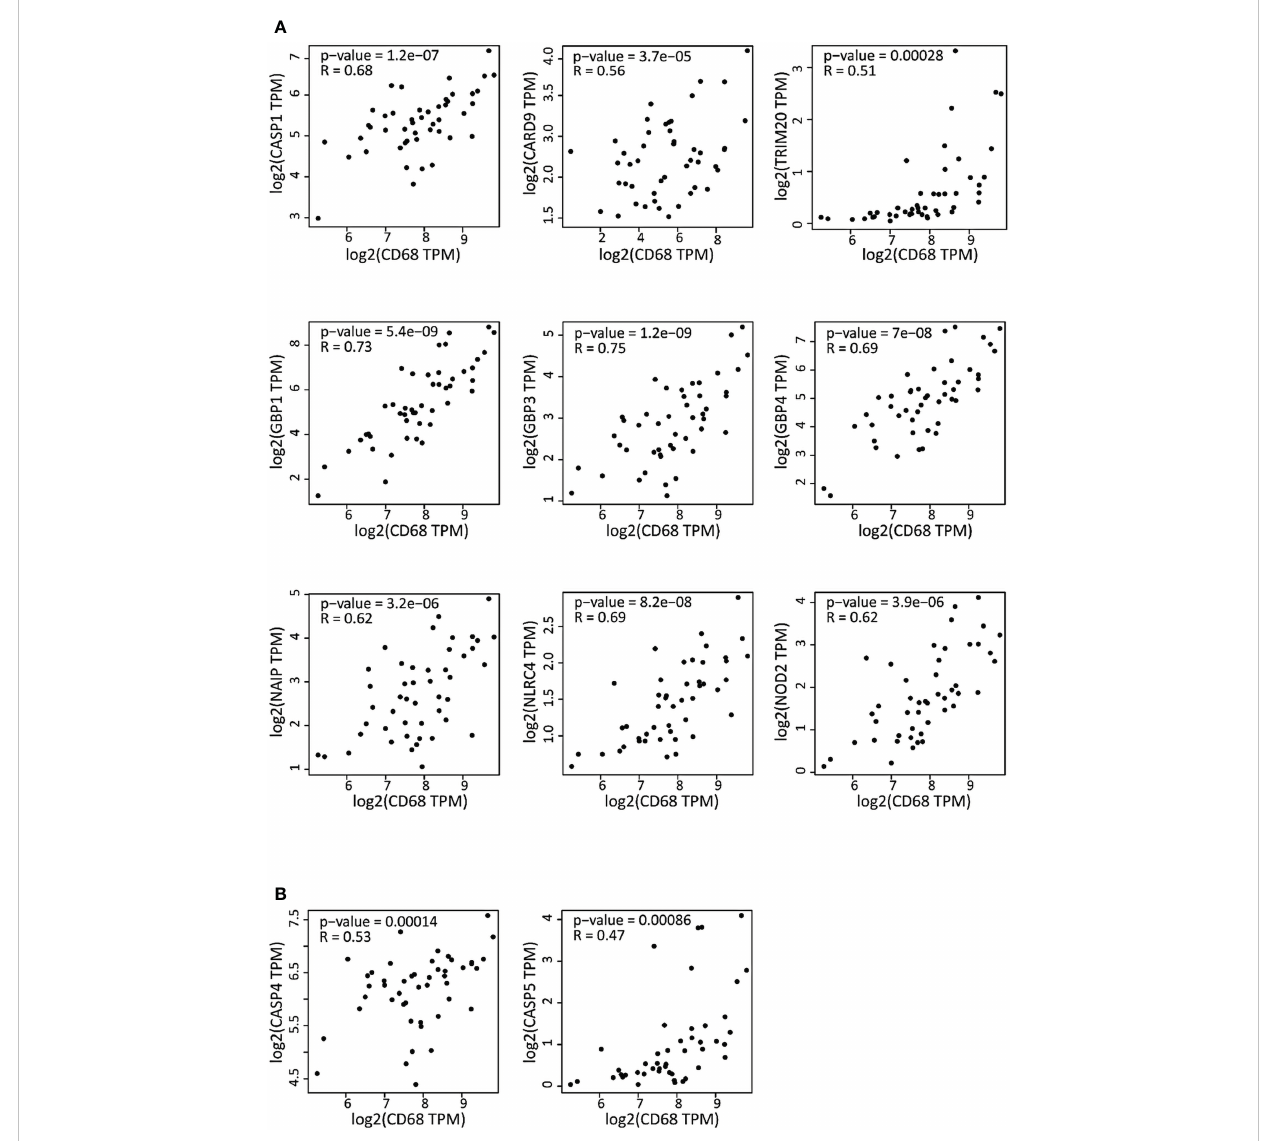
FIGURE 2 Correlation of the expression of in fl ammasome genes and of the CD68 macrophage marker in DLBCL samples (A) Correlation between the expression of the canonical in fl ammasome genes and CD68 in 47 DLBCL samples (TCGA database). (B) Correlation between the expression of non-canonical in fl ammasome genes and CD68 in the same DLBCL samples. Quantitative comparison based on the Pearson ’ s correlation coef fi cient (R). Y-axis: log2 (TPM) of the in fl ammasome gene expression level, X-axis: log2 (TPM) of CD68 expression level. TPM, transcript count per million